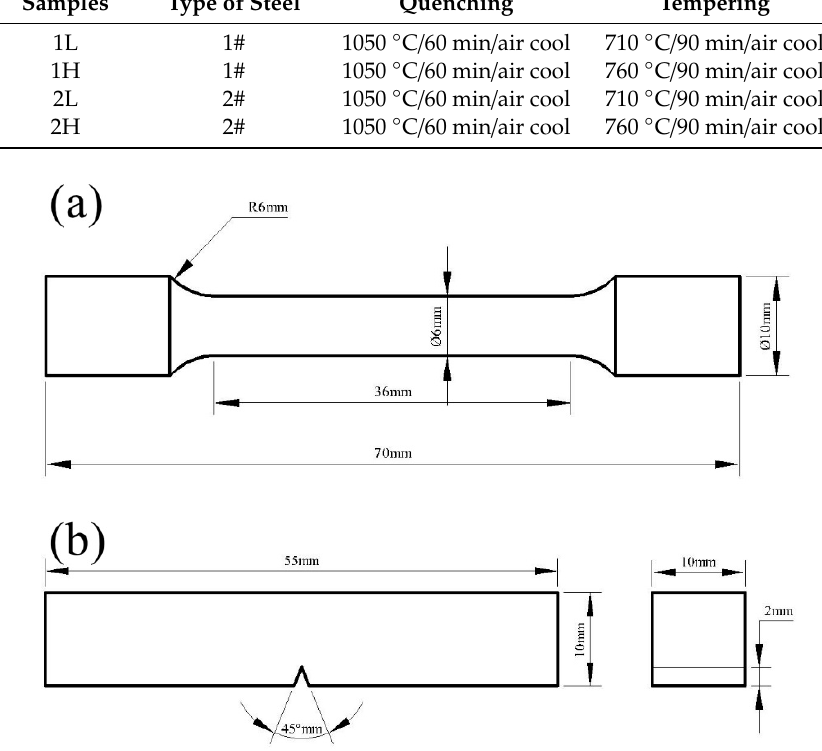
Figure 1. Shape and dimensions of tensile specimen ( a ) and Charpy shock specimen ( b ).